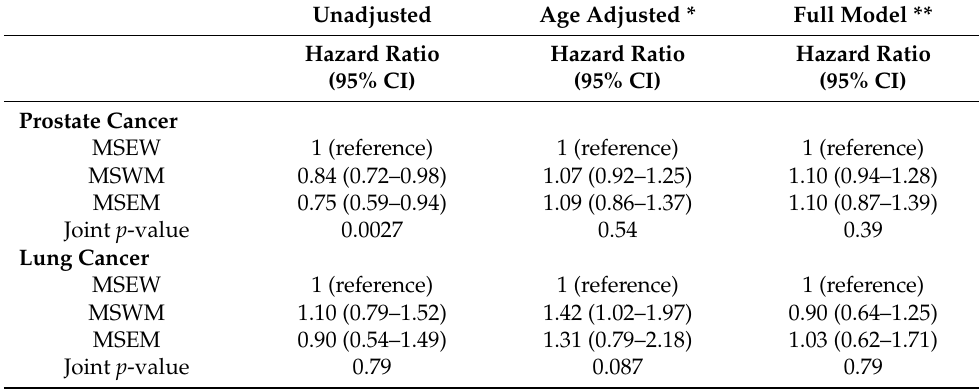
Table 5. Models of prostate, lung, and colorectal cancer in